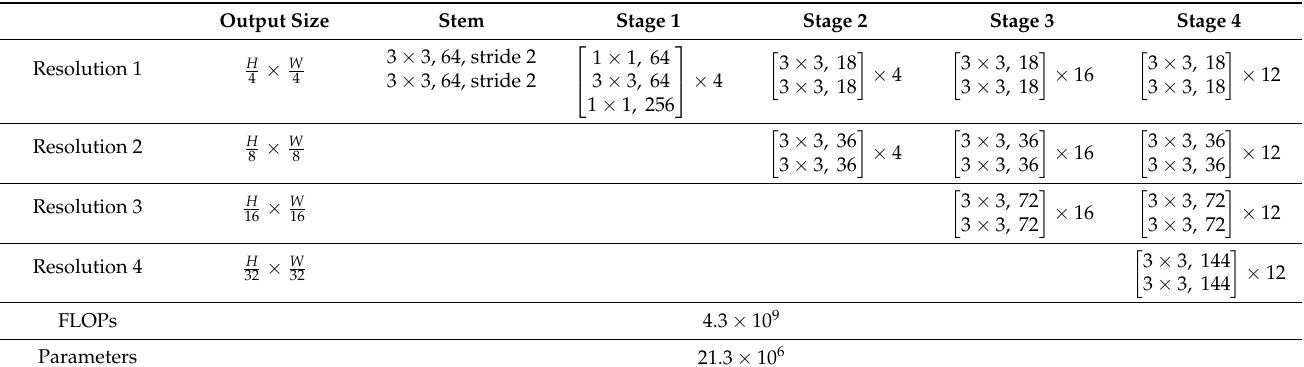
Table 3. Detailed architecture specifications of HRNet-w18, where the bracket indicate a residual block, and the number outside the brackets is the number of stacked blocks for the